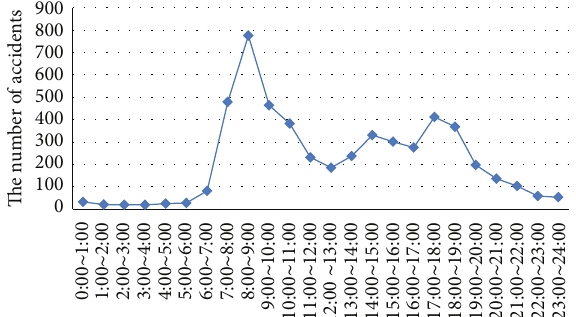
Figure 5: Hourly distributions of traffic